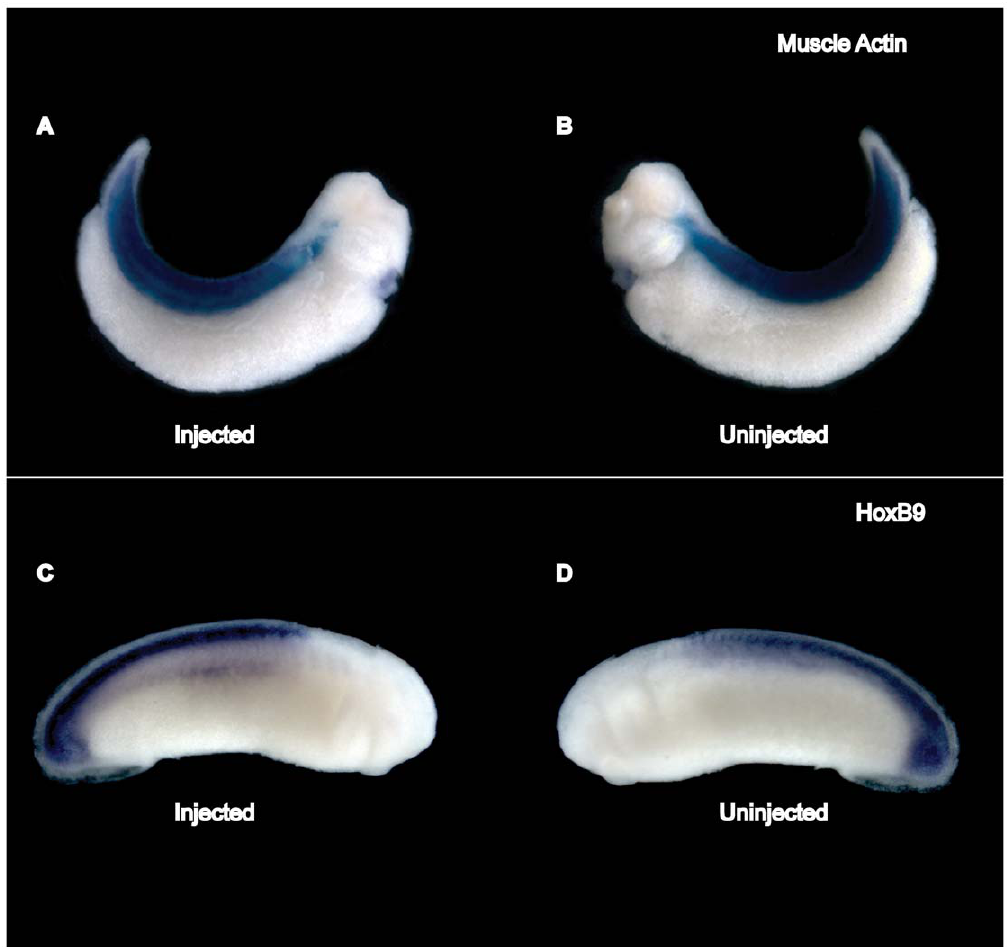
Figure 5. Loss of SPC7 function does not affect mesodermal and posterior neuroectodermal marker expression patterns. Whole mount hybridization in situ of embryos injected unilaterally with 90 ng SPC7 morpholino. Injected sides are shown to the left. (A, B) Lateral views of stage 35 embryo showing that muscle actin (dorsal mesoderm) staining was equally visible in both the injected and uninjected sides of the embryo. (C, D) Lateral views showing that HoxB9 (posterior neuroectoderm) expression was equally apparent in the posterior dorsal region of the embryo in both the injected and uninjected sides.